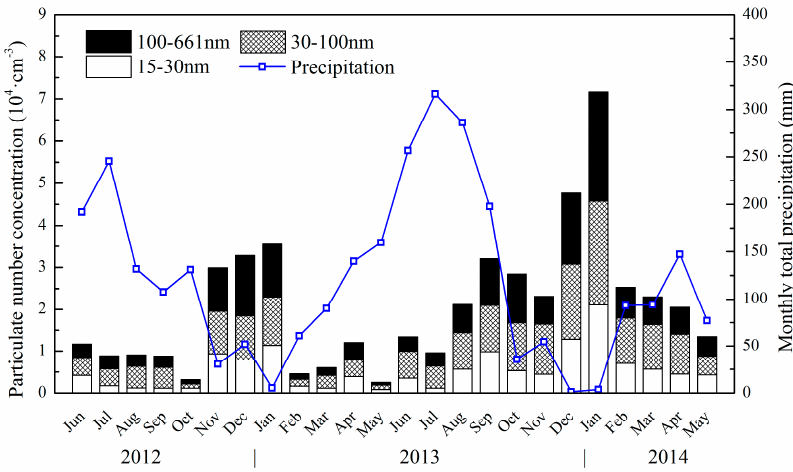
Figure 2. Monthly variation in particle number concentrations for the three modes and monthly total precipitation, where the blank, gridded, and black areas represent the nucleation, Aitken, and accumulation modes, respectively, and the blue hollow squares represent the monthly total precipitation. Figure 3 shows the seasonal variation in wind speed, mixing layer height, temperature, and RH during the two-year experiment. There were obvious seasonal variation patterns for temperature and wind speed. The average temperature and wind speed in summer were approximately 29 °C and 2.2 m·s − 1 , respectively, which were clearly higher than they were in other seasons. Average RH in summer was lower than it was in other seasons, possibly caused by extremely high temperatures in summer, whereas the relatively higher RH in other seasons may have been affected by the geographic location, i.e., lying on the Yangtze River. Moreover, the mean value of mixing layer height was approximately 500 m, which was a little higher in summer and autumn, which is significantly lower than it was in Beijing, namely 1100 m in annual average [59] and Lanzhou,